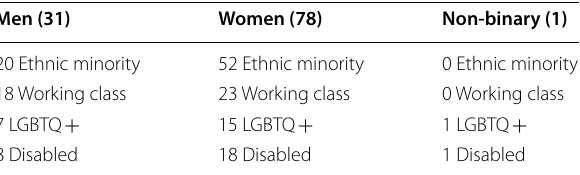
Table 1 Student demographic background by gender, ethnicity, class and disabled